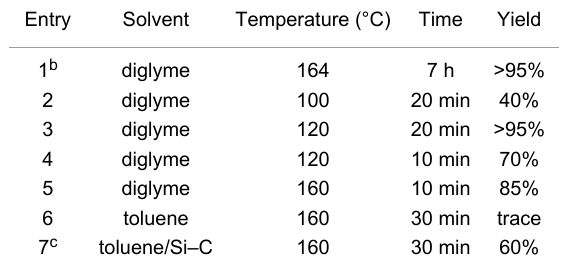
Table 3: IEDDA reaction conditions of 13a to give cycloadduct 14a .